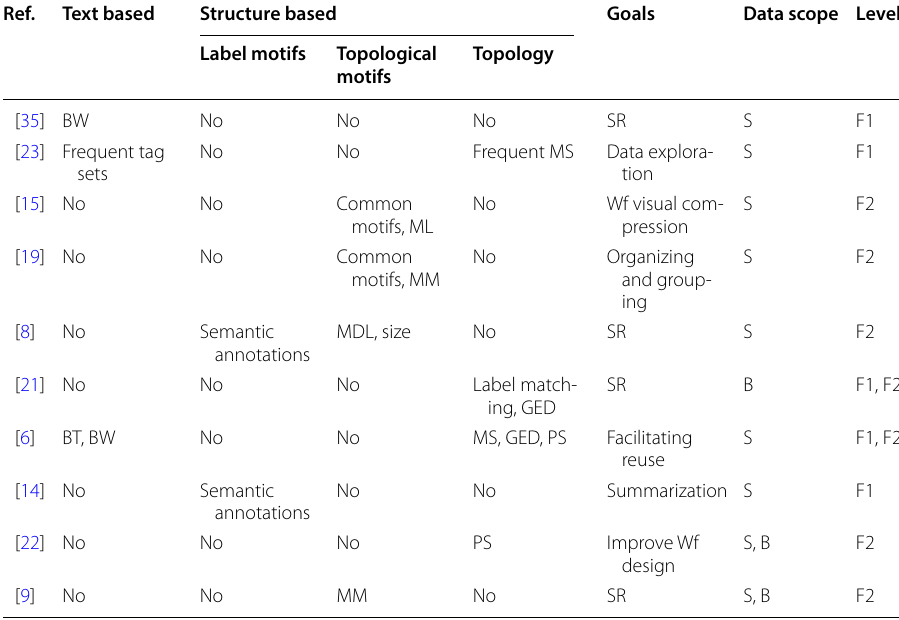
F1 single‑component, F2 multi‑component, S scientific, B business